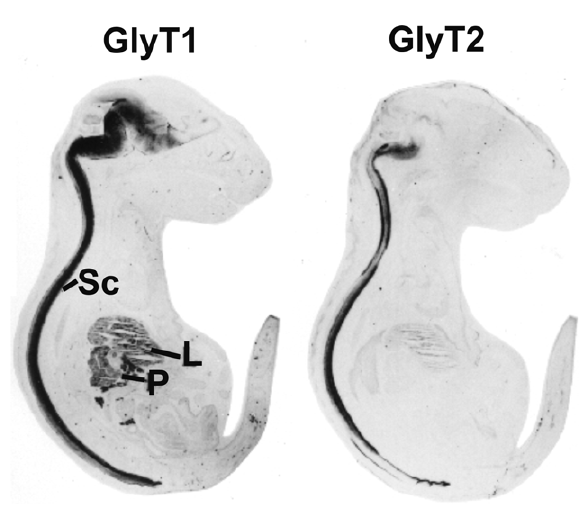
Figure 3. Distribution of GlyT1 and GlyT2 in sections from mouse E18 embryos. Note that GlyT2 immunoreactivity is mostly confi ned to spinal cord (Sc) and brainstem, while GlyT1 is also expressed in some higher brain regions and peripheral tissues, especially liver (L) and pancreas (P). Reproduced